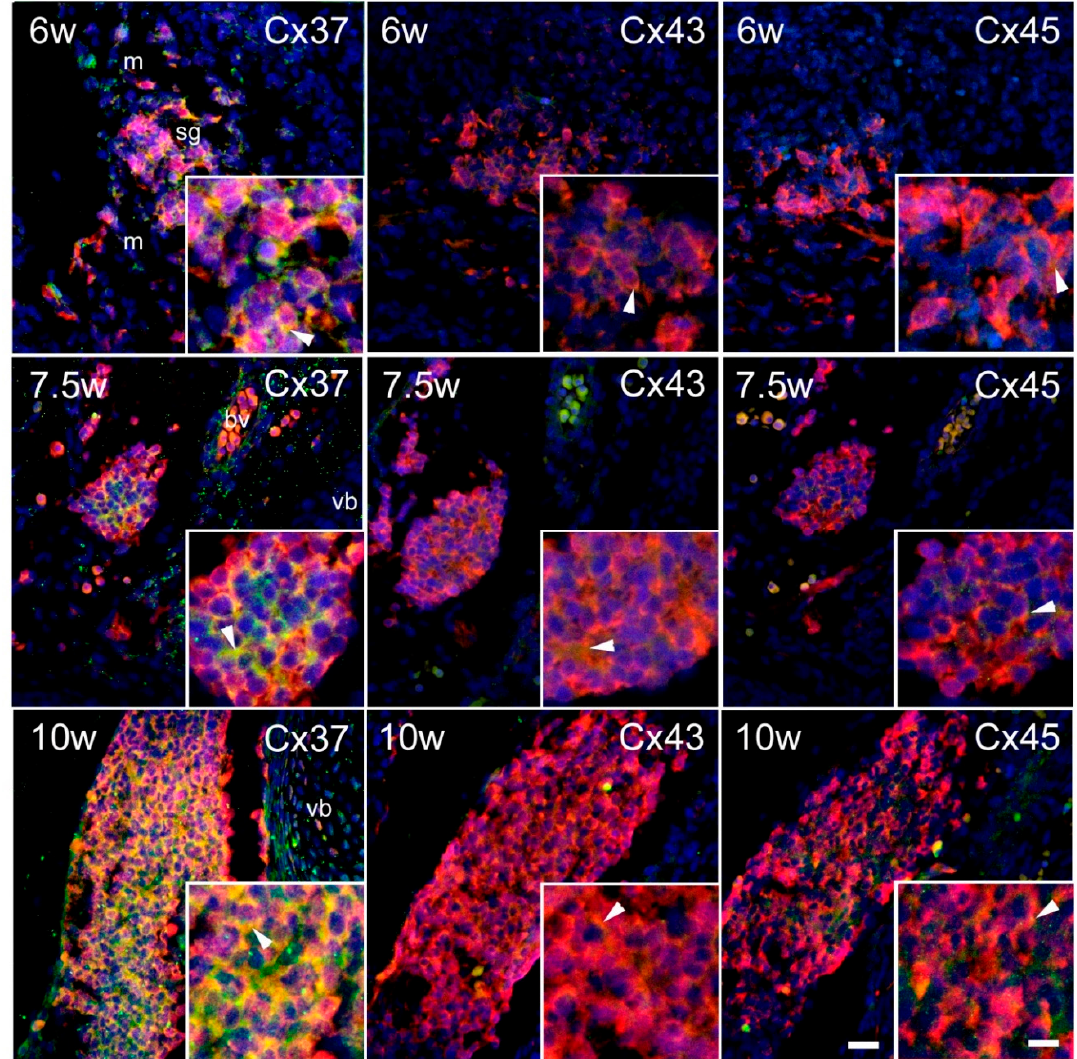
Figure 6. Expression of Cxs 37, 43, and 45 in the sympathetic (paravertebral) ganglia (sg) of the human conceptuses. Thoracic segments of the SC of 6, 7.5, and 10 week-old human conceptuses were stained for Cx37, Cx43, and Cx45 (green), and PGP9.5 (red). sg are presented on photomicrographs. Objective magnification—10 × (scale bar = 80 µ m); insets—40 × (scale bar = 20 µ m). Arrowheads are pointing to the yellow granular pattern of Cx / PGP9.5 co-localization in the cytoplasm of developing sympathetic neurons.